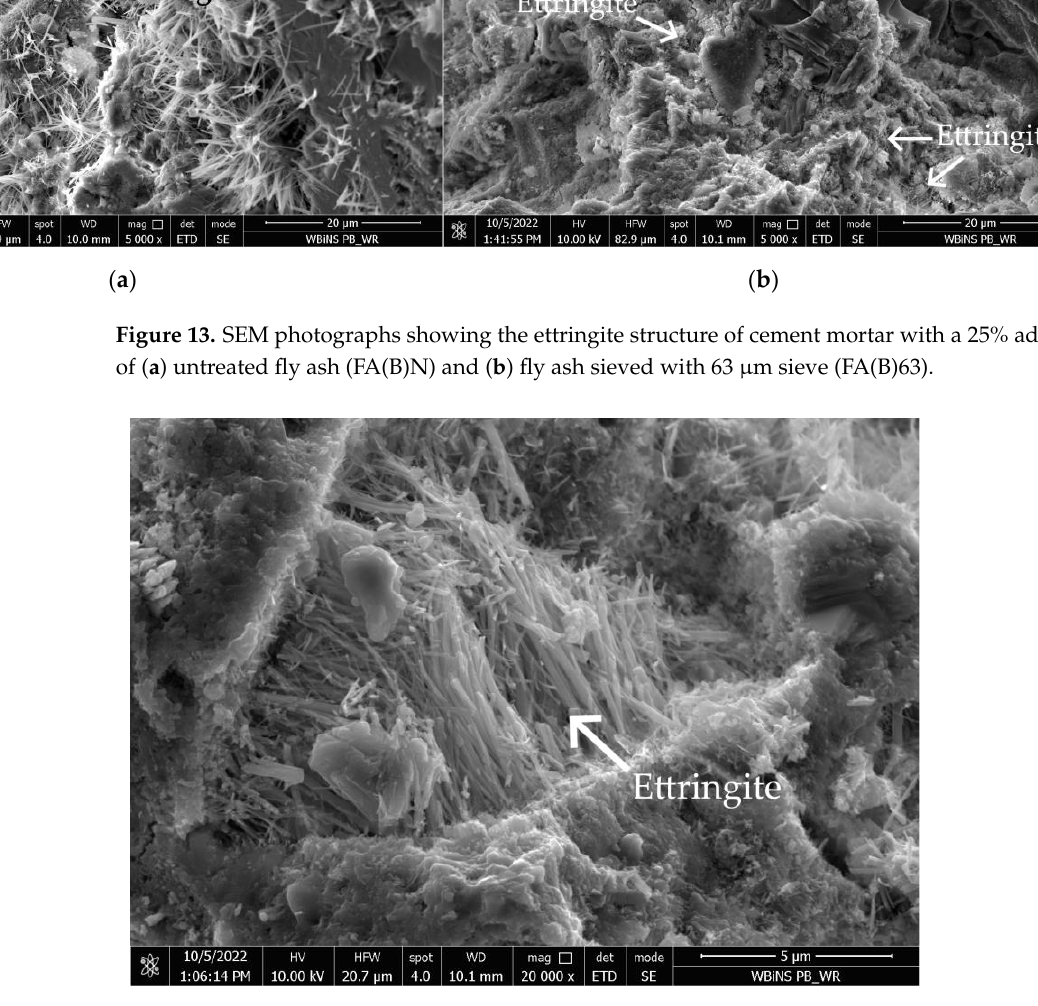
Figure 14. A close-up SEM photograph showing the ettringite structure of cement mortar with a 25% addition of fly ash sieved with 63 µm sieve (FA(B)63).